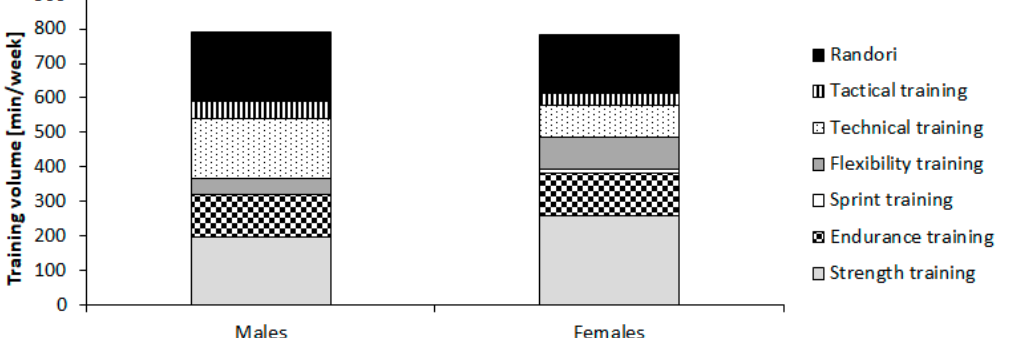
Figure 1. The distribution of the different training types across the entire season in young male and female judo athletes.